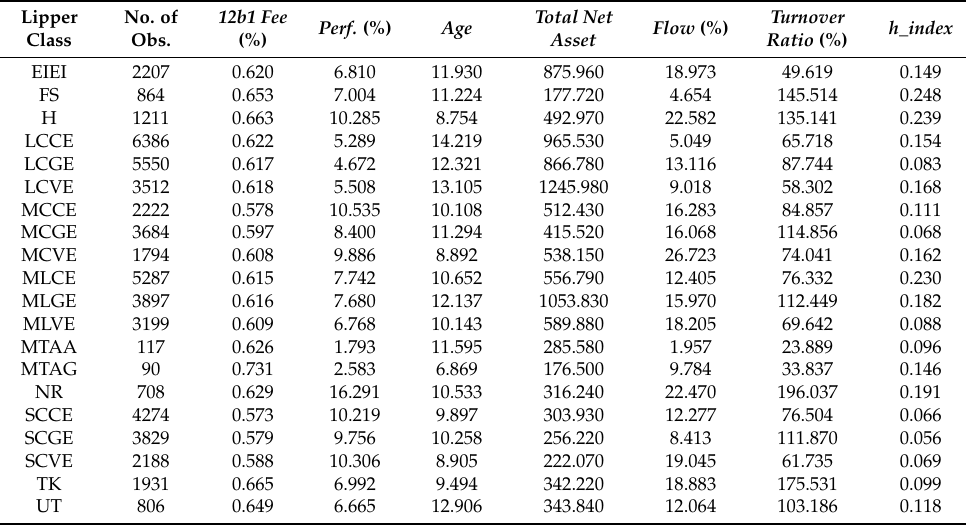
Table 2. Fund characteristics and competition by Lipper